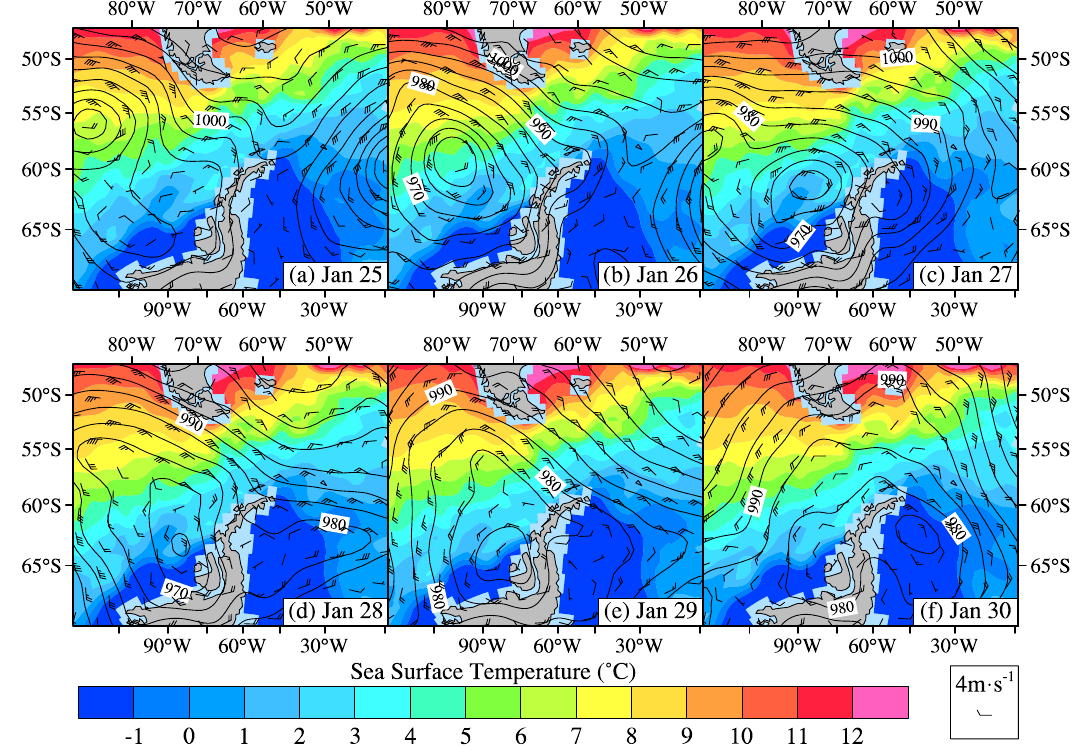
Figure 3. Composite map of National Centers for Environmental Prediction (NCEP) SST (color shading), sea level pressure (black contour), and wind (black barb) at 10 m above sea level around the Drake Passage at 1200 UTC on 25–30 January 2017 ( a – f ).